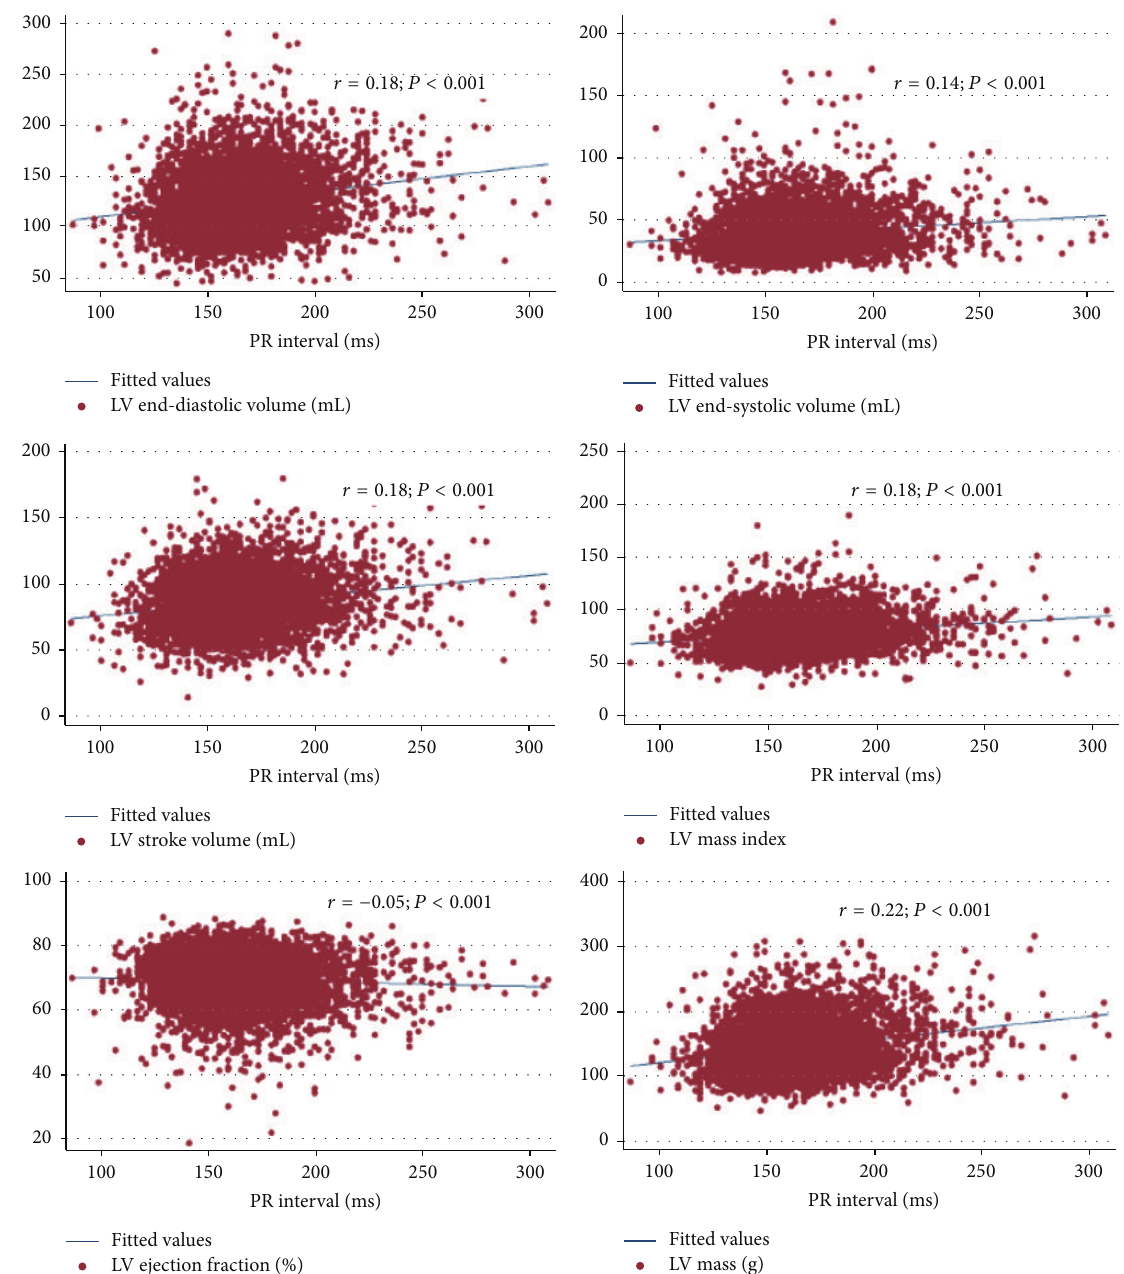
Figure 1: Scatterplots of PR interval by left ventricle dimensions, left ventricle mass index, and ejection fraction.